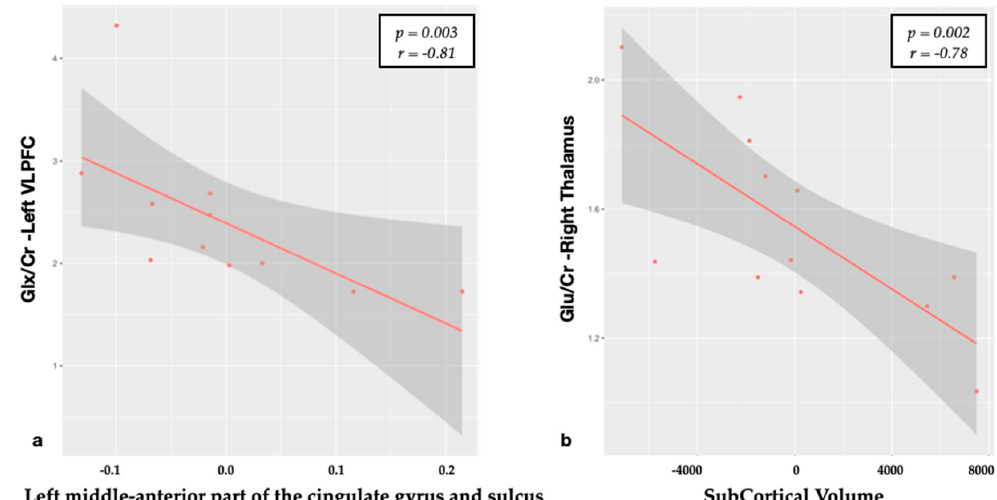
Figure 3. Correlation between metabolite ratios and cortical thickness. ( a ) The Spearman’s correlation of Glx/Cr in the left VLPFC and cortical thickness of left middle anterior part of the cingulate gyrus (residuals); ( b ) Spearman’s correlation of Glu/Cr in the right thalamus and subcortical gray matter volume (residuals).